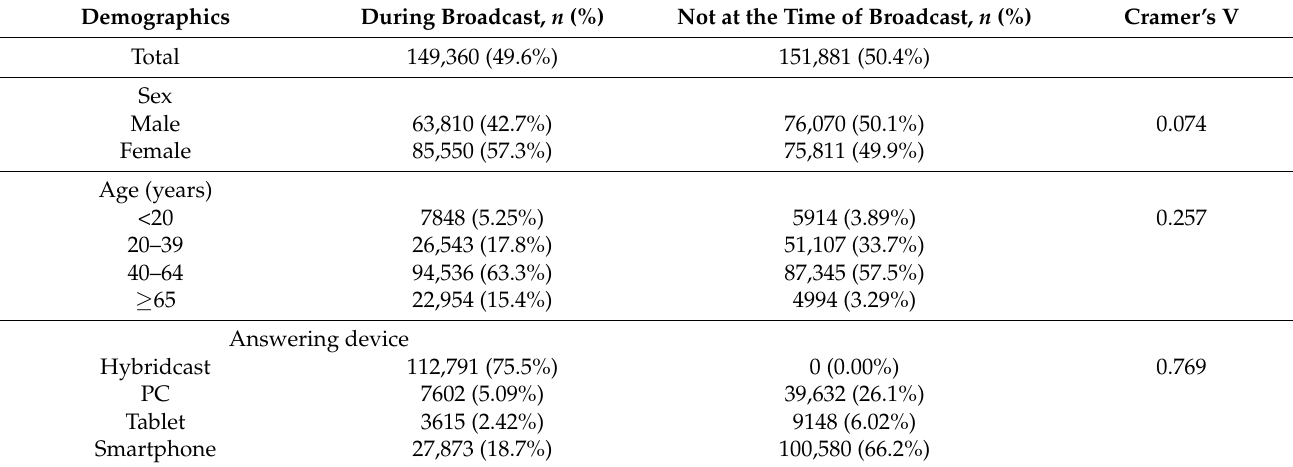
Table 5. Comparison of recording time of responses and demographic